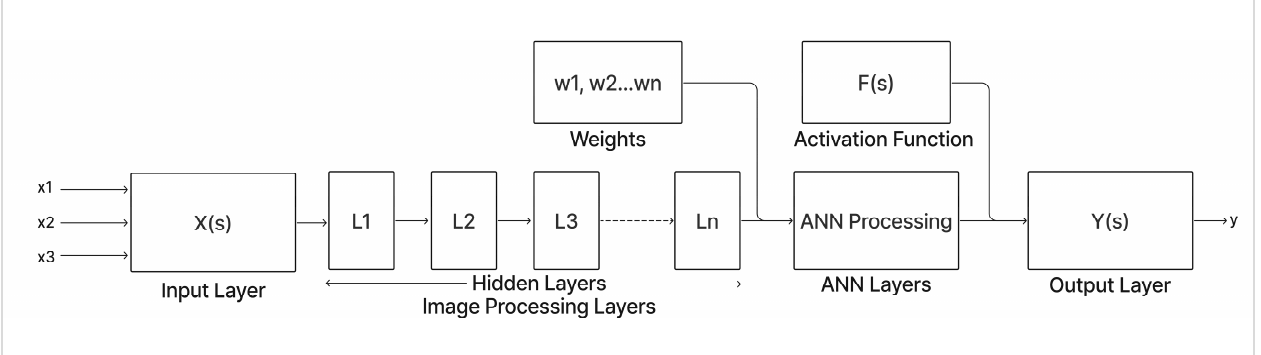
Figure 3. Block Diagram of CNN model.